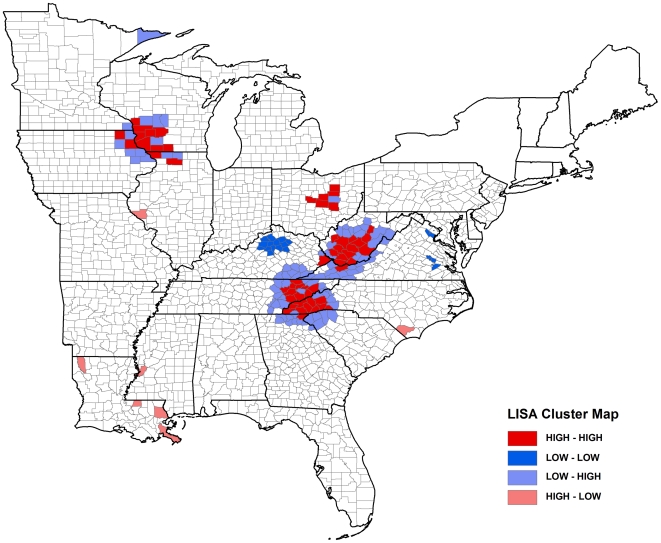
Spatial patterns of disease risk in children 15 years and younger.This map shows the significant clustering of La Crosse virus infections at the county level detected by the Moran's I Local Indicators of Spatial Autocorrelation (LISA) for the eastern United States. Four types of spatial autocorrelation are observed using the LISA statistic (High-High, Low-Low, High-Low, and Low-High). Positive spatial autocorrelation is represented by High-High and Low-Low, and negative spatial correlation by High-Low and Low-High. Positive spatial autocorrelation (i.e. an association of areas of similar values) were represented as either High-High (i.e. a high risk in an area surrounded by similarly high values in neighboring areas) or Low-Low (i.e. a low risk in an area surrounded by similarly low values in neighboring areas). Negative spatial autocorrelation (i.e. an association of areas of dissimilar values) was represented as either High-Low (i.e. a high rate in an area surrounded by low values in neighboring areas) or Low-High (i.e. a low rate in an area surrounded by high values in neighboring areas).